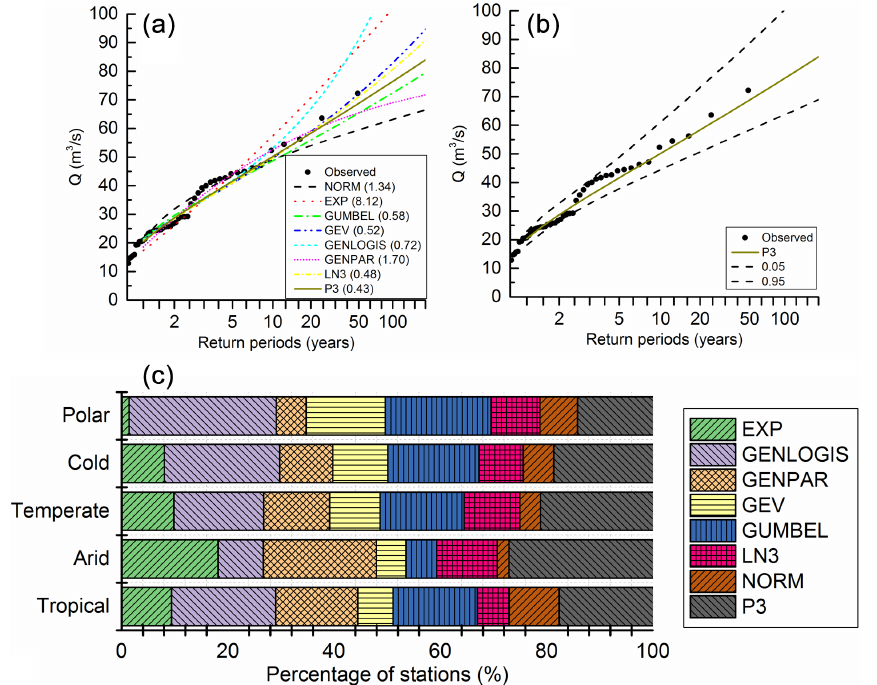
Figure 4. Flood frequency curve selection and estimation. (a) Flood frequency curve selection of station no. AT0000032 ( A 2 value in brackets). (b) Design flood estimation of station no. AT0000032 using the Bayesian MCMC interface. (c) Selection results of flood frequency curve for all